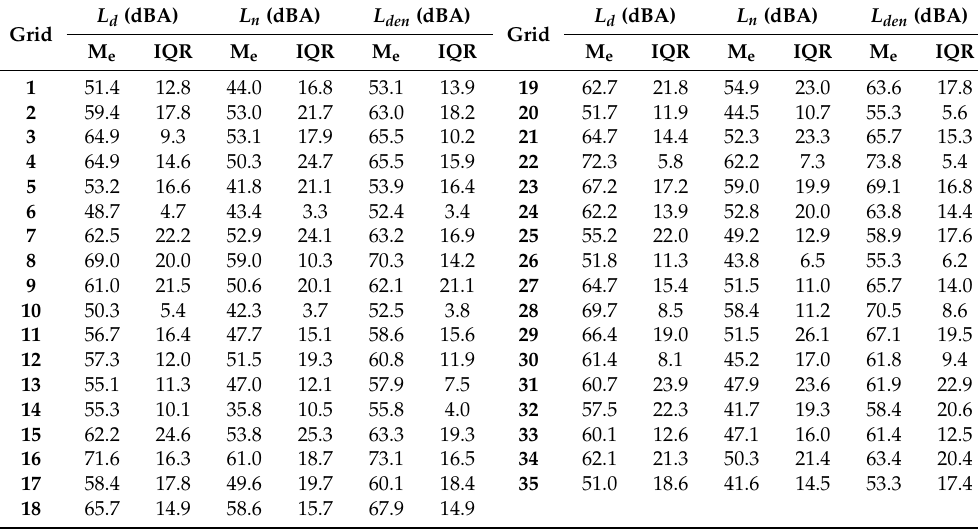
Table 1. Median (M e ) and interquartile range (IQR) of L d , L n and L den descriptors registered in the square grids.